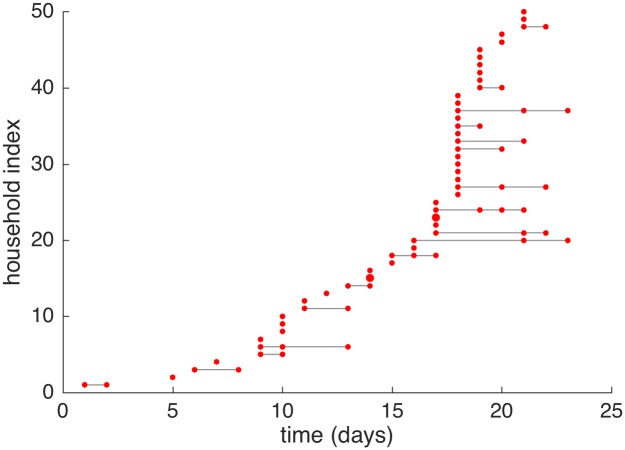
A realisation of the SIR household model.The households are all of size 3 and the model is described in the Models and Methods section. The times of symptom onset, binned into days, in the first 50 infected households at the beginning of an epidemic outbreak are presented. The size of points corresponds to the number of infections on that day. The lines provide a visual reference to link infections within the same household.